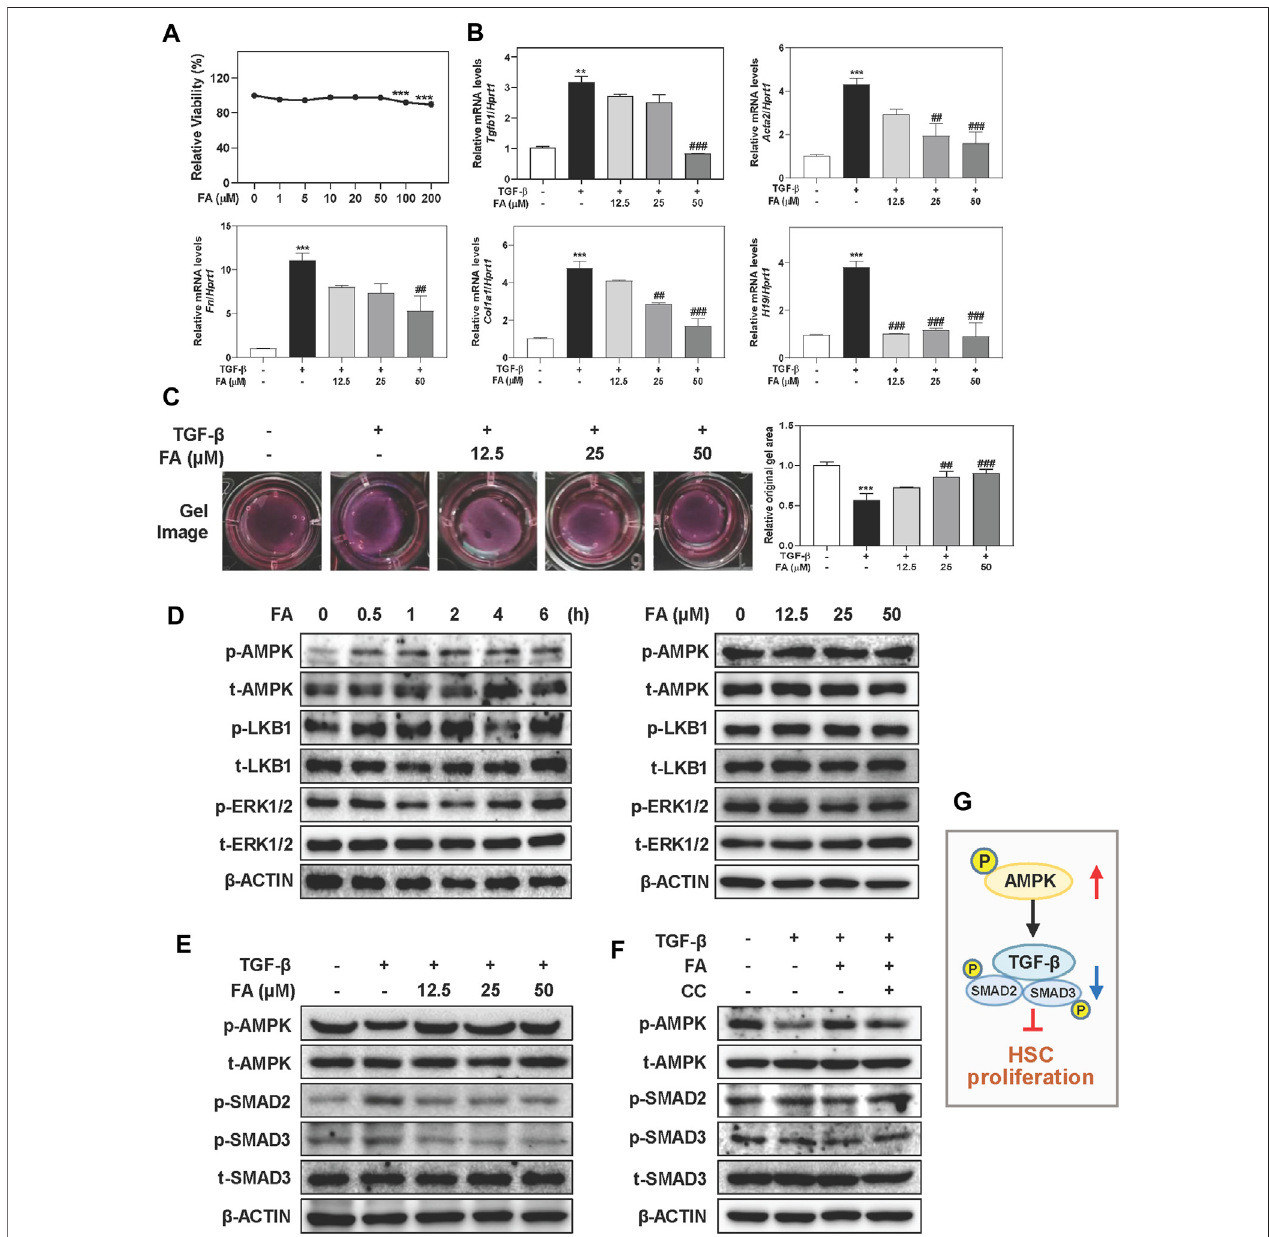
FIGURE 4 | FA attenuates TGF- β -induced HSC activation and fi brotic responses in LX-2 cells. (A) A CCK-8 assay. After pre-treated with FA at different concentrationsfor1 h,LX-2 cellsweretreatedwithTGF- β (5 ng/ml)foranother24 h (BandC) or6 h (E) . (B) RelativemRNAlevelsofTgfb1,Acta2, Fn,Col1a1andH19 weredetermined byqPCR and normalized using Hprt1 as aninternal control. (C) Representativecollagen gel images from three independent experiments were shown. (D) LX-2 cells were treated with 25 μ M FA at different time points or different concentrations of FA for 24 h. (F) After treated with CC (2 μ M) or FA (25 μ M) or both, LX-2 cells were administrated with TGF- β for another 6 h (D-F) Representative immunoblots against p-AMPK, t-AMPK, p-LKB1, t-LKB1, p-SMAD2, p-SMAD3, t-SMAD3, p-ERK1/2, t-ERK1/2 and β -ACTIN were shown. (G) The pathway of AMPK, TGF- β and SMADs involved in HSC proliferation. Statistical signi fi cance: ** p < 0.01, *** p < 0.001, compared with control group; ## p < 0.01, ### p < 0.001, compared with TGF- β group. One-way ANOVA with Tukey ’ s post-hoc tests ( n (cid:1)